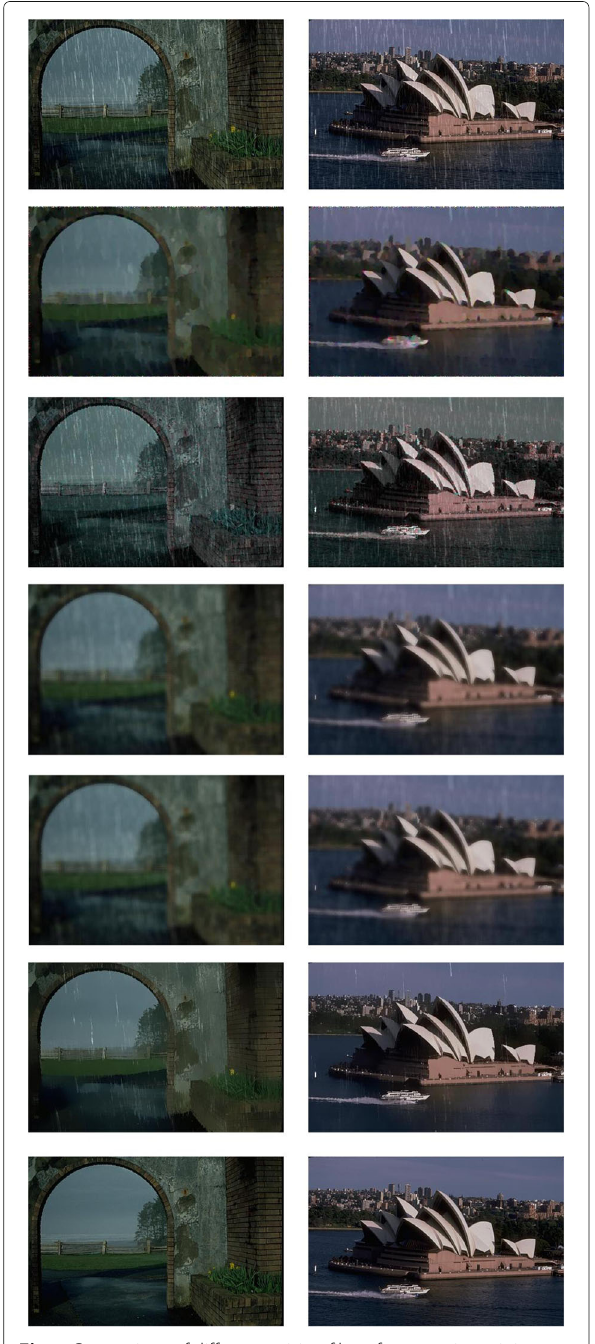
Fig. 5 Comparison of different noising filters for removing raining. The top row is the input rainy images, follows in sequence are the results with Gaussian filter, median filter, bilateral filter, guided filter, the weighted median filter, and the ground